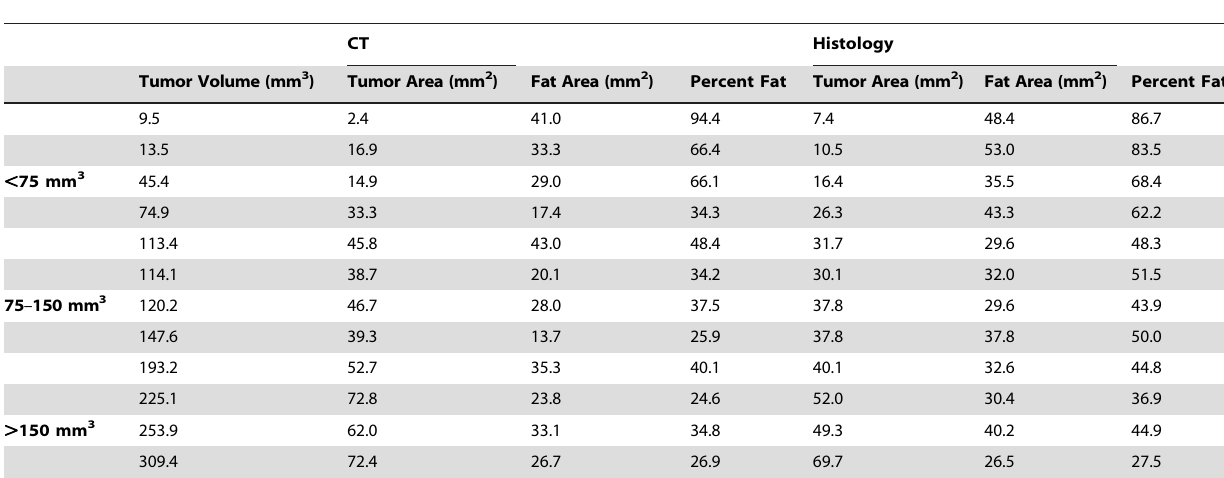
Table 2. Area measurements of tumor region and surrounding fat pad from CT and Histology.